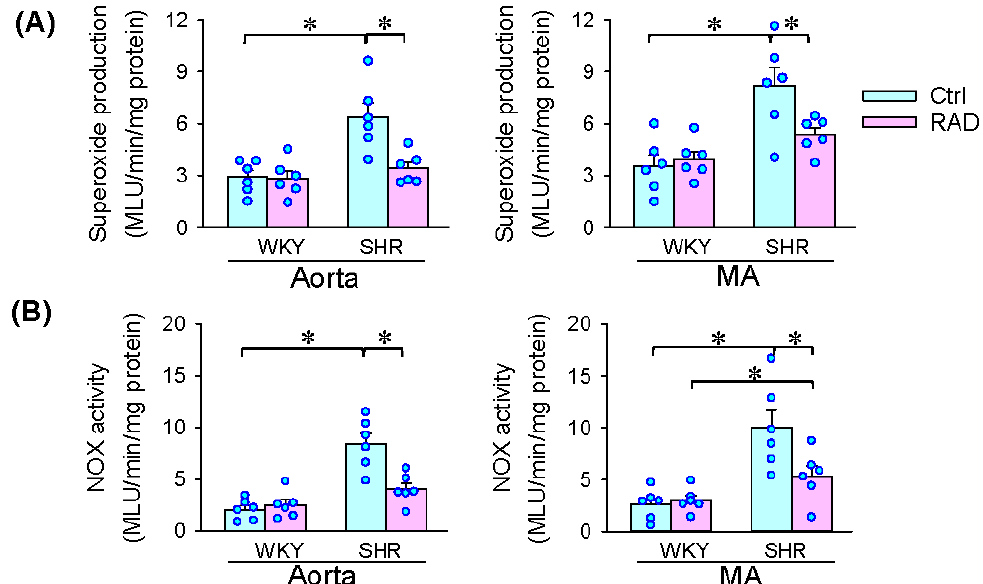
Figure 6. Effects of RAD on superoxide production and NOX activity in the aorta and mesenteric artery of WKY and SHR. ( A ) Superoxide production. ( B ) NOX activity. Values are mean ± SE. Two-way ANOVA followed by Bonferroni’s post hoc analysis were used for comparisons. * p < 0.05. n = 6 for each.